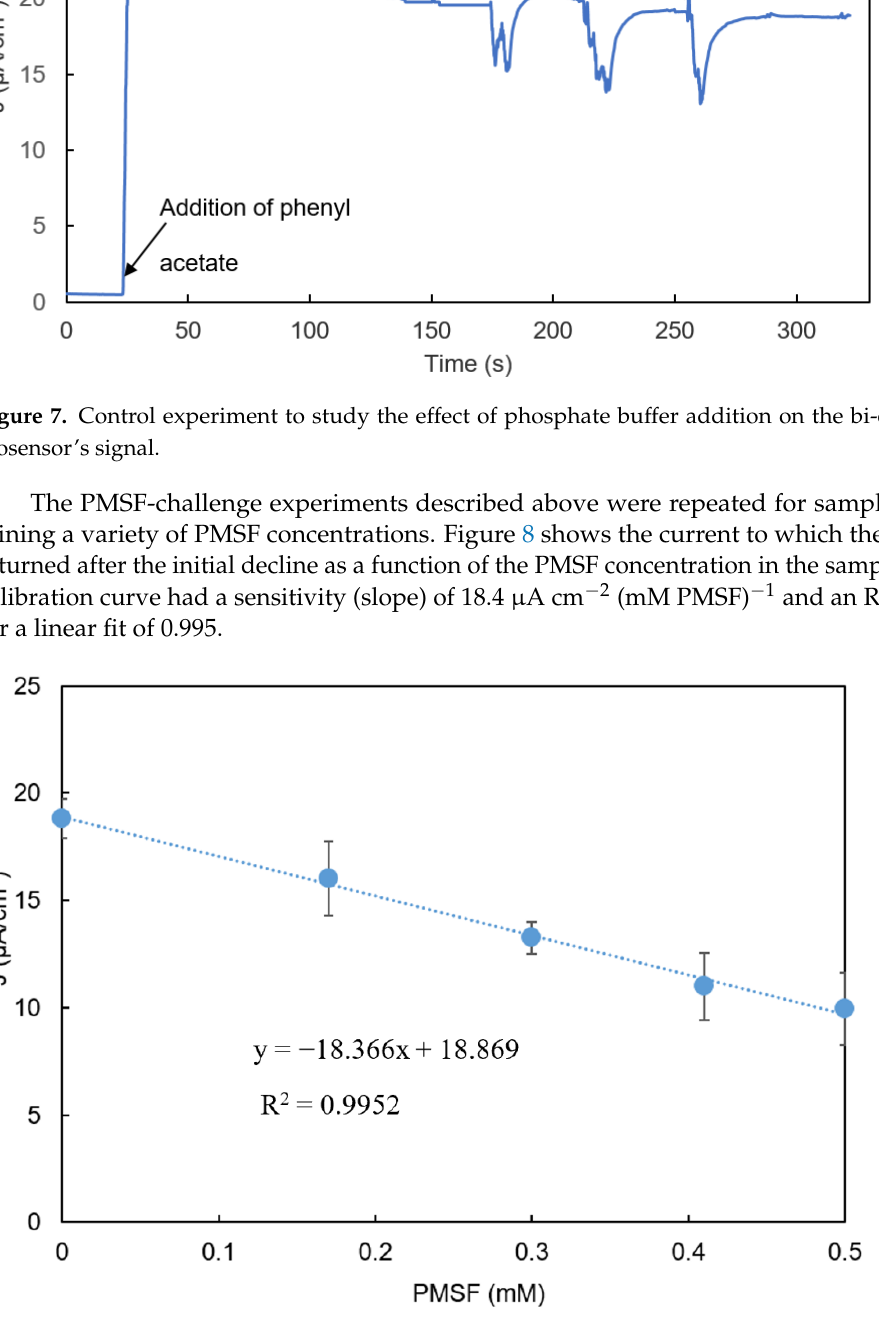
Figure 8. Current vs. PMSF concentration. Error bars indicate the mean ± standard deviation of three replicates. Phenylacetate: 0.9 mM. y = − 18.366x + 18.869, R 2 = 0.9952.